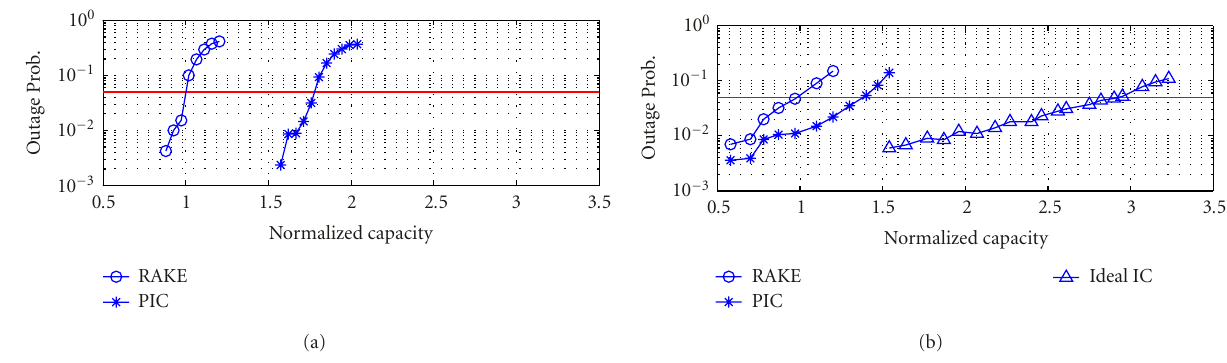
Figure 8: Simulated system performance relative to the performance with a conventional RAKE for (a) a single-cell scenario and (b) a multiple-cell scenario.